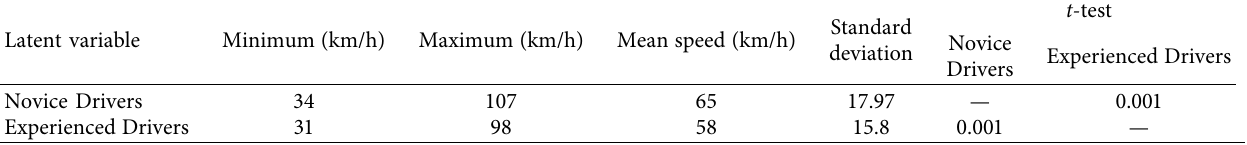
Table 11: Speed statistics related to the latent variables “Novice Drivers” and “Experienced Drivers.”